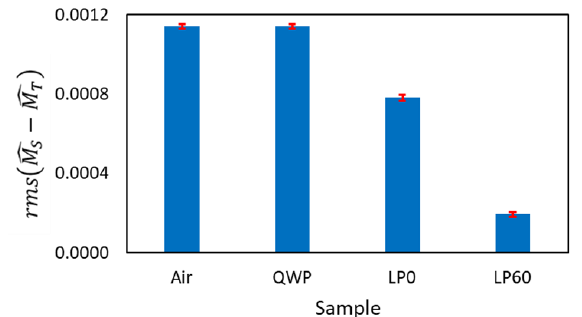
Fig. 3. Mean values and standard deviations of the root squared differences between the Mueller matrices obtained from numerical simulations and the ideal ones. For four samples: air, a linear polarizer with horizontal transmission axis (LP0) and with its transmission axis at 60º with respect to the horizontal (LP60), and a quarter wave phase (QWP) retarder with its fast axis along the horizontal direction.